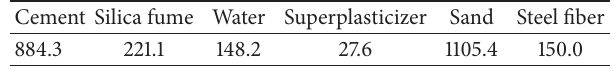
Table 1: Mix proportion of RPC200/kg ⋅ m −3 .